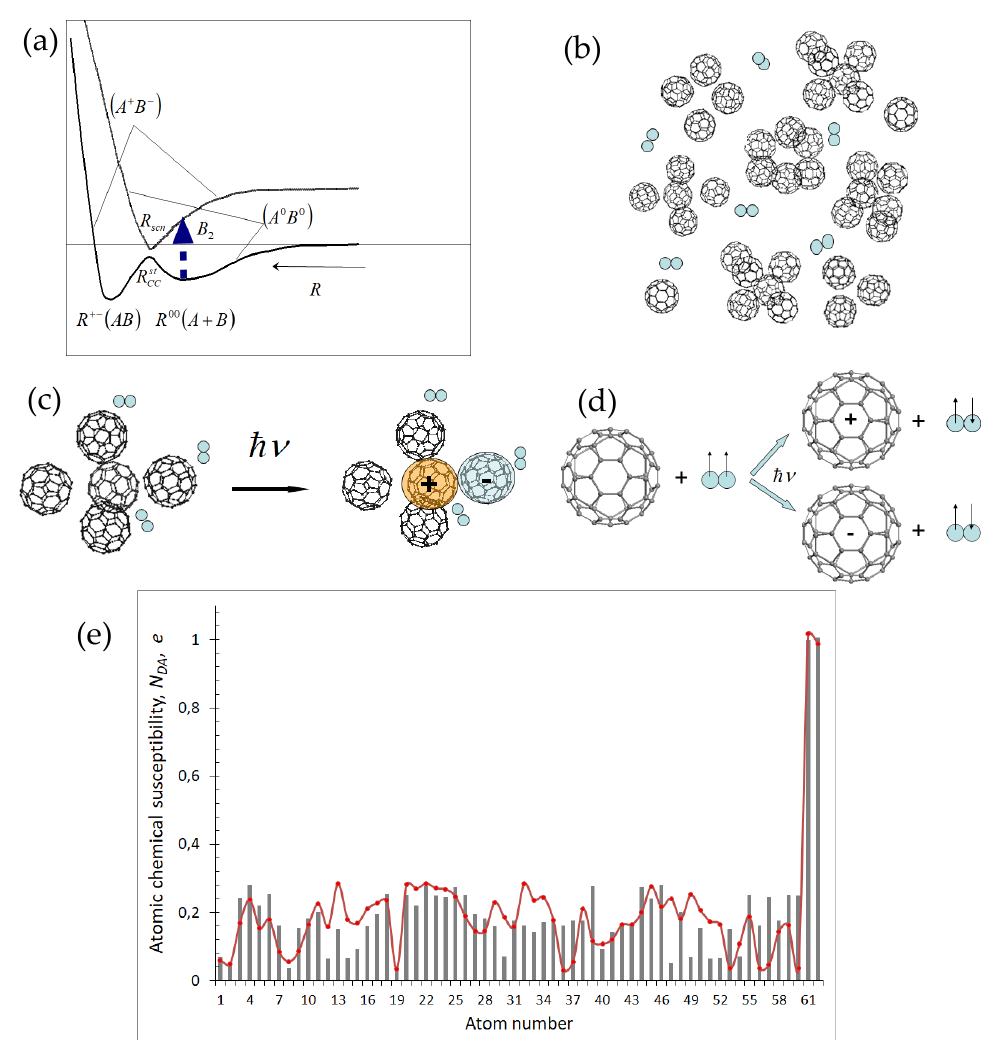
Figure 5. Photodynamic effect of the [ C 60 + O 2 ] complex. ( a ) Scheme of the IMI terms related to the interaction between two fullerene molecules. ( A 0 B 0 ) and ( A + B − ) match branches of the terms related to the interaction between neutral molecules and their ions, respectively. R + − and R 00 mark minimum positions attributed to the formation of tightly bound dimer (AB) and weakly bound charge transfer complex (A 0 + B 0 ), respectively. R scn indicates the point of avoidable intersection of terms ( A 0 B 0 ) and ( A + B − ). ( b ) Schematic presentation of fullerene clusterization in solution. ( c ) The formation of an ionic pair of C 60 under photoexcitation. The only ion pair is formed under photoexcitation of the ( C 60 ) n cluster of any content. ( d ) Schematic presentation of the spin-flip in oxygen molecule under photoexcitation. ( e ) ACS distribution over atoms of (cid:3) (cid:3) 2 [ C − + O + O (histogram) and 2 [ C + (red curve) 2 2 60 60